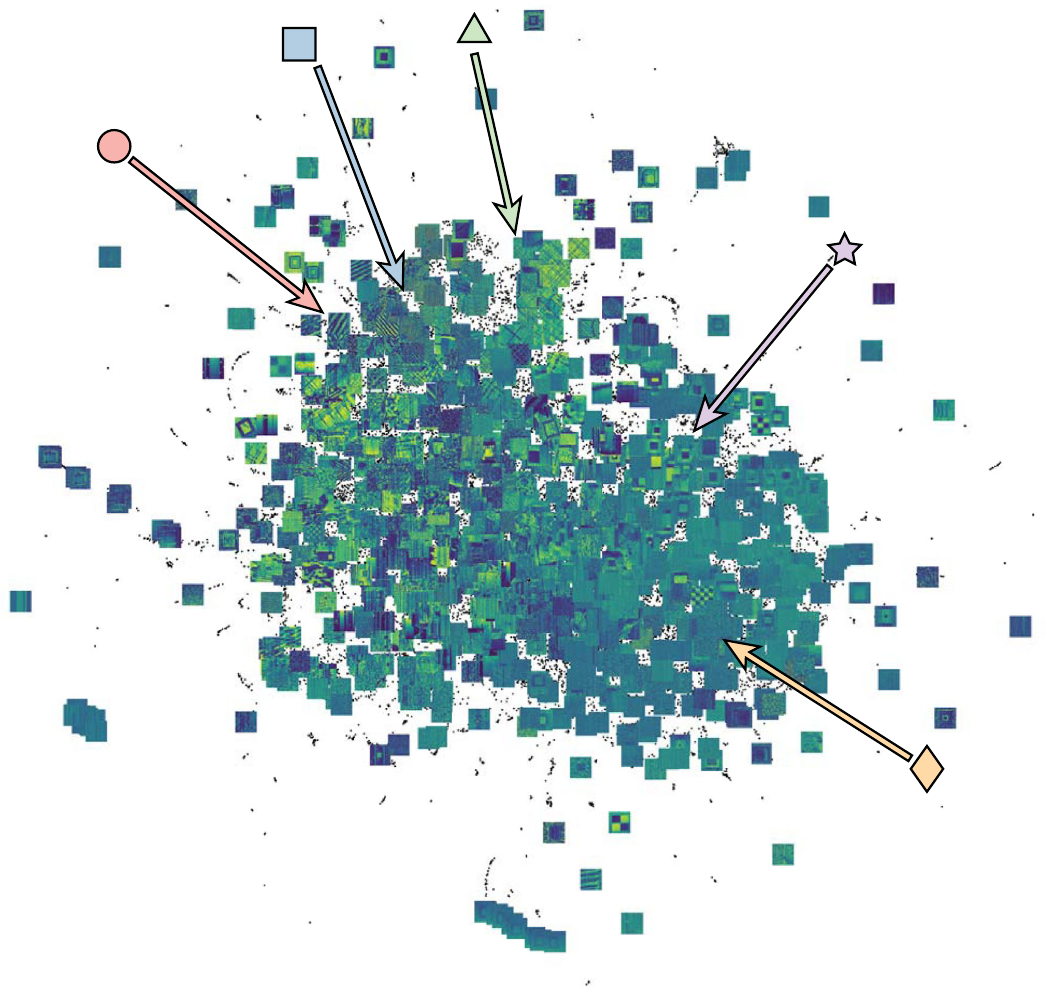
Fig. 3 UMAP representation of 25,133 piezoresponse force microscopy images. The hyperparameters for the UMAP were n_neighbors = 5, min_dist = 0.3, n_components = 2, metric = “ correlation ” . Only the amplitude channel is